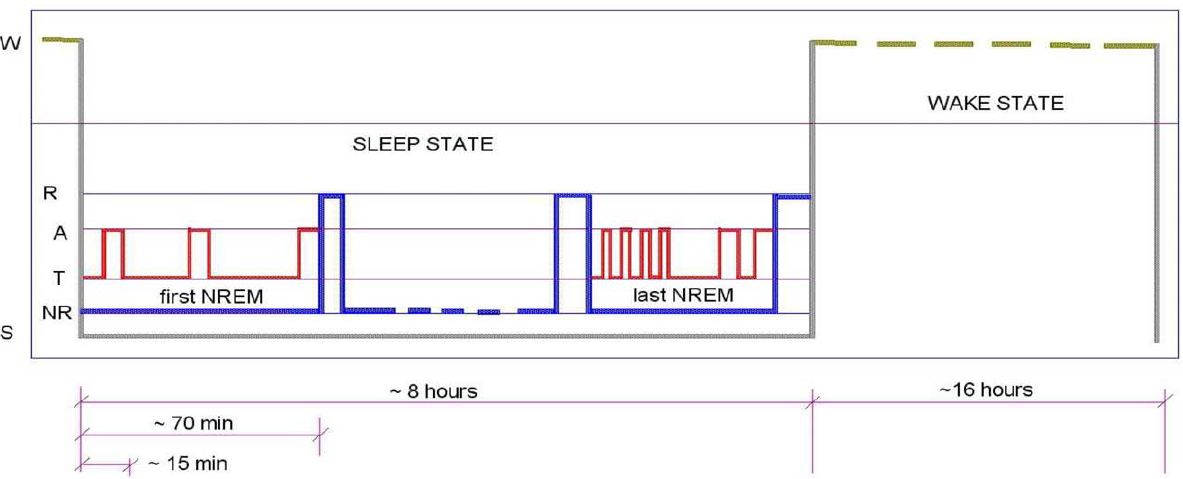
Figure 8. Overview of SCN sleep timers. As we see it, the SCN, influenced by feedback from several sources in particular homeostatic drives, has all the information necessary to provide sleep timing flip-flops not only for wake-sleep (W-S) and NREM-REM (NR-R) transitions but also for the towards (T) and away (A) switchovers within NREM. Thus there would appear to be a progressive penetration of SCN control into all layers of the complex behaviour that is sleep: in the outer layer a control of the circadian process (wake-sleep alternation), in the next layer a control of the ultradian process (NREM-REM alternation) and in the next deeper layer a control of the process responsible for NREM sleep structure ( towards and away alternation within NREM).